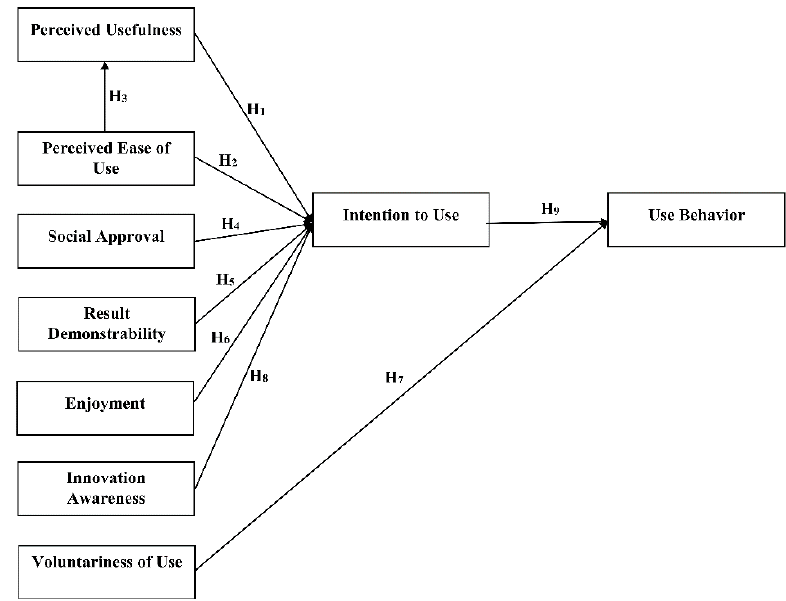
Figure 1. Research